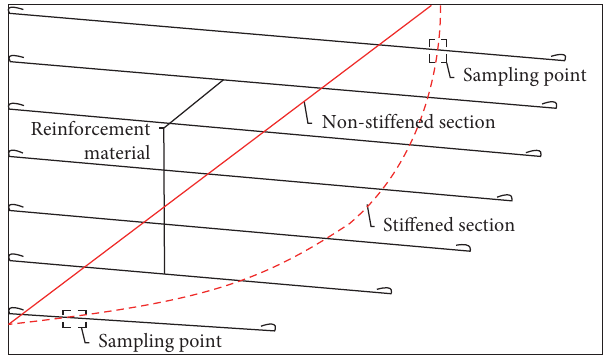
Figure 3: Diagram of the failure plane of reinforced walls.